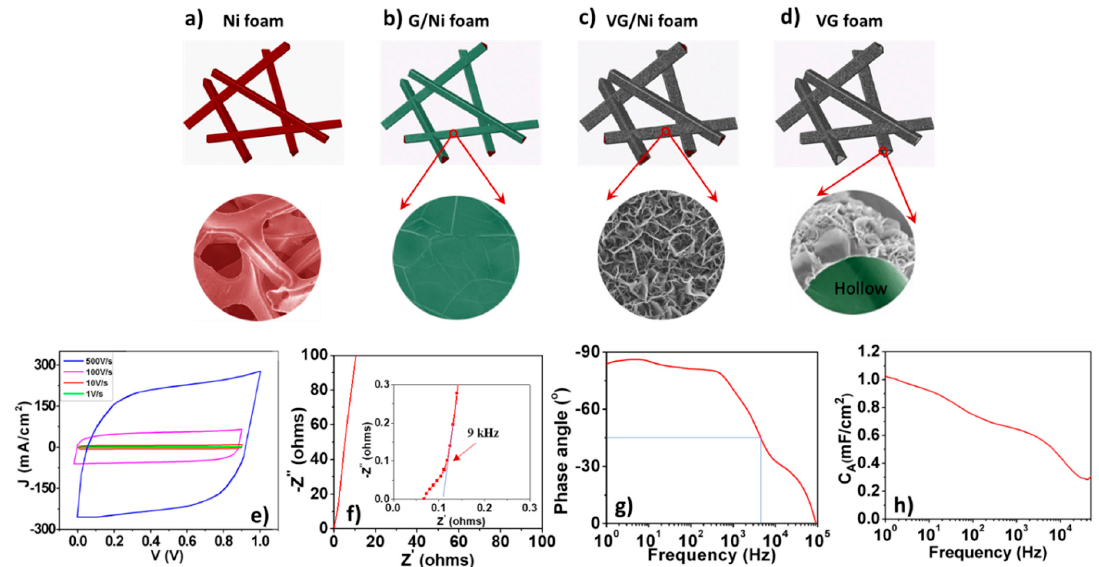
Figure 3. Schematic and the corresponding SEM images showing the morphology changes of ( a ) Ni foam, ( b ) G/Ni foam, ( c ) VG/Ni foam, and ( d ) freestanding VG foam after Ni is etched off. VG/Ni foam-based HF-EC performances: ( e ) CV profiles up to 500 V s − 1 , ( f ) complex impedance spectrum (inset is the enlarged part at high frequency range. The electrode area is 1.7 cm 2 .), ( g ) calculated electrode capacitance vs. frequency based on the RC model, and ( h ) the phase angle vs. frequency plot. Reproduced with permission from Ref. [42] for ( a – d ), Copyright 2016, and Ref. [5] for ( e – h ), Copyright 2014, Elsevier.